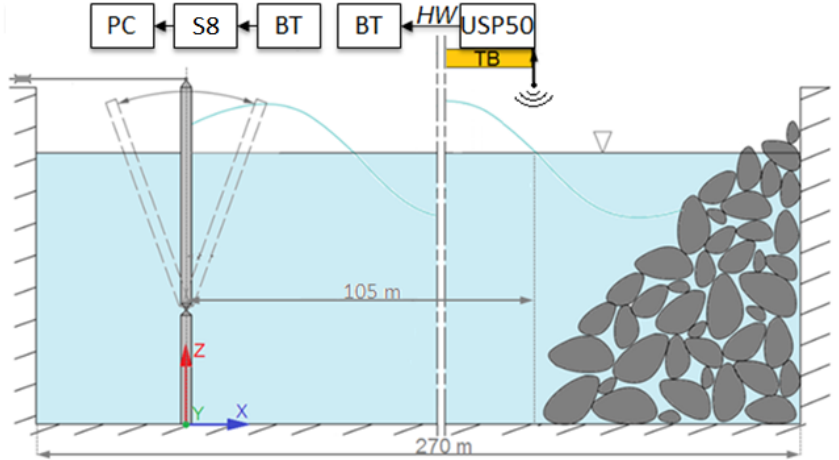
Figure 12. The structural diagram of the measurement system used for the measurement of waves: the measurement ultra-sound device USP50 , installed to a towing carriage TB , wireless Bluetooth modules BT for transmission of the measured signal HW and the data acquisition module S8 with a personal computer PC